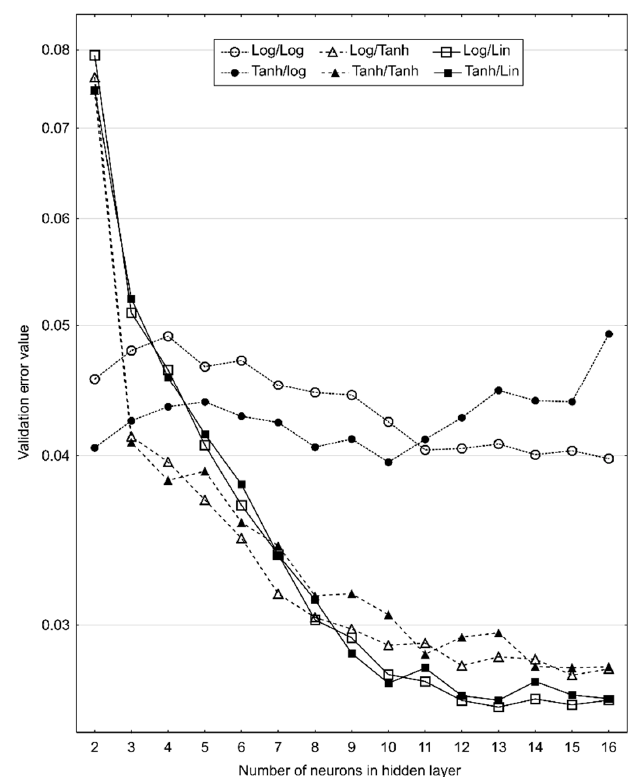
Figure 2. Changes in mean values of ( a ) training and ( b ) test errors of MLP networks applied to model mold contamination in a bulk of rapeseeds with water activity a w = 0.75–0.90 stored at 12–30 °C depending on the number of neurons in the hidden layer for each applied combination of activation functions (hyperbolic tangent (Tanh), logistic (Log), and linear (Lin)) in neurons of hidden and output layers).